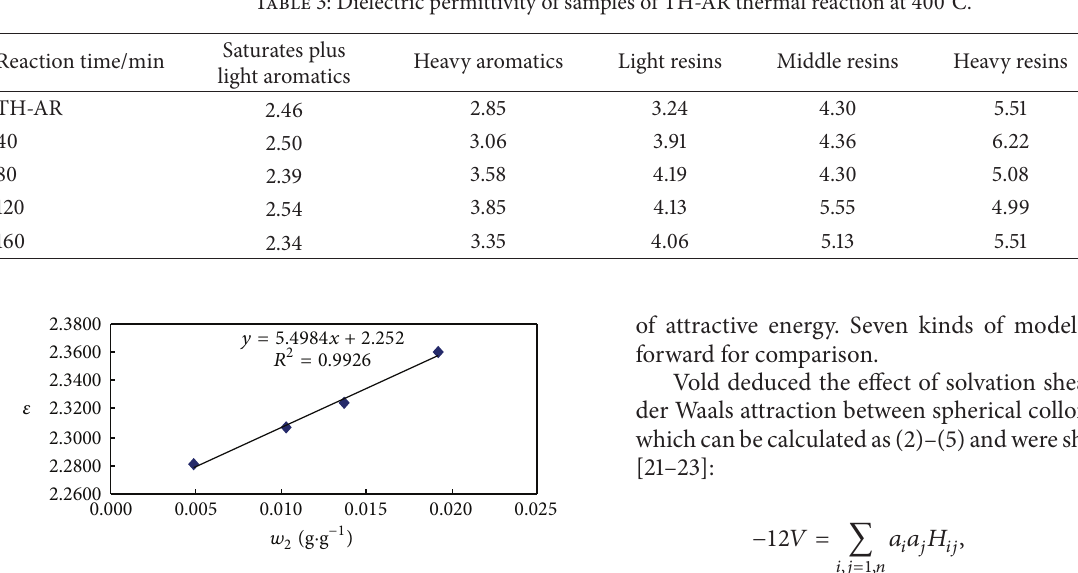
Figure 1: The dielectric permittivity values as a function of con- centration for solution of asphaltenes of TH-AR thermal reaction sample for